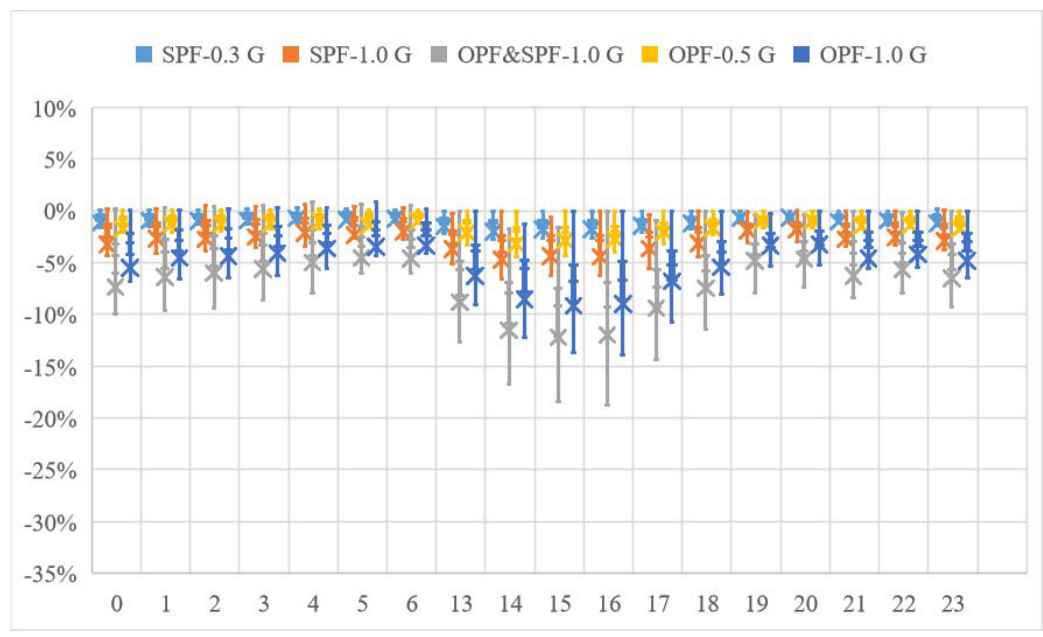
( e ) Box charts for hourly percentage difference in a year for tests for Ground Floor, (1) Extended Side-fin at a length with Side-fin Projection Factor at 0.3; (2) Extended Side-fin at a length with Side-fin Projection Factor at 1.0; (3) Extended Side-fin and Overhang at a length with Side-fin Projection Factor at 1.0 and Overhang Projection Factor at 1.0; (4) Extended Overhang at a length with Overhang Projection Factor at 0.5; (5) Extended Overhang at a length with Overhang Projection Factor at 1.0;. Figure A1. Annual percentage di ff erence distribution of cooling load vs. hours of days on ground floor. Figure A1. Annual percentage difference distribution of cooling load vs. hours of days on ground Note: The unit for the x-axis is %di ff , the unit for the y-axis is hour. floor. Note: The unit for the x-axis is %diff, the unit for the y-axis is hour.